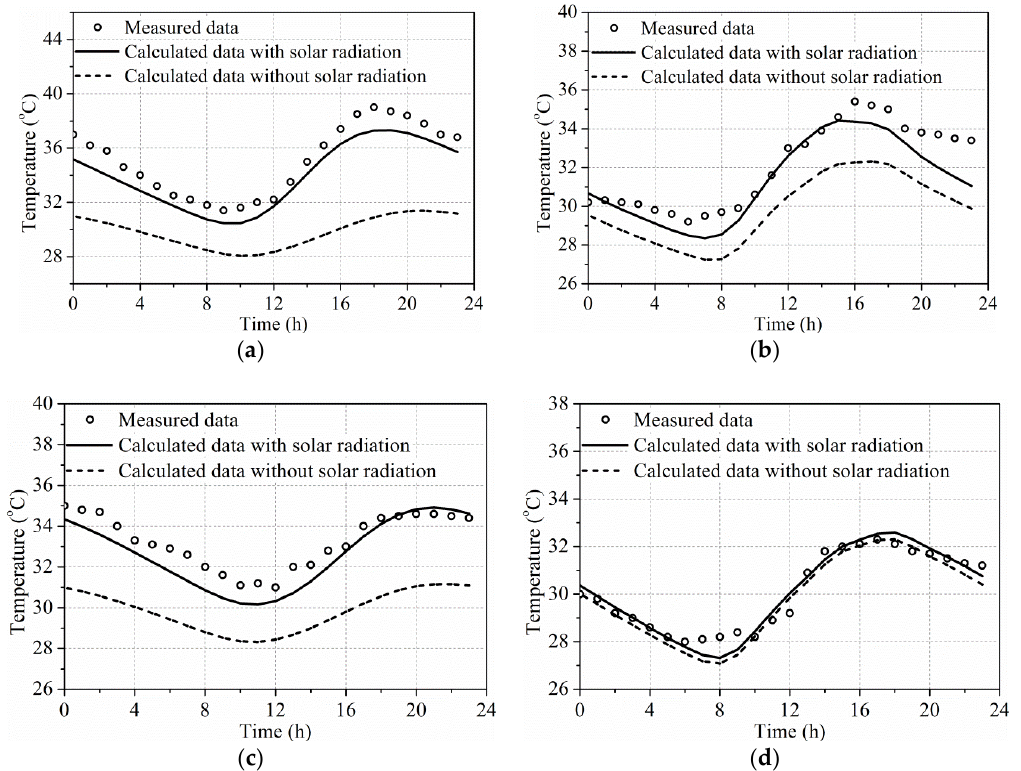
Figure 21. Influence of solar radiation on temperature distribution on cross-section of T-shaped girder in summer: ( a ) top flange (T-1); ( b ) web (1-W); ( c ) web (2-W); and ( d ) bottom flange (4-B).